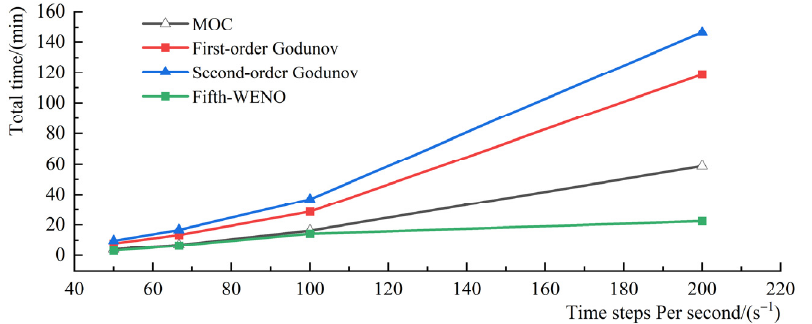
Figure 11. Comparison of calculation speed of different simulation methods. Table 4. Effect analysis table of GPU acceleration.